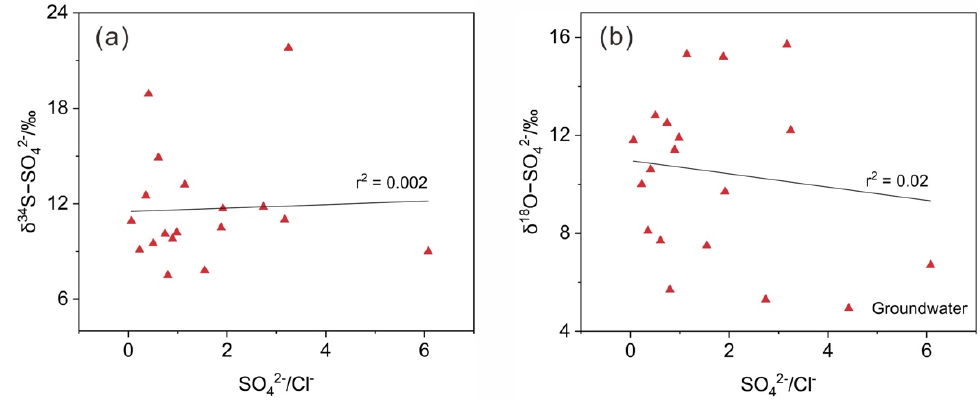
Figure 7. Relationships among δ 34 S − SO 42 − and δ 18 O − SO 42 − and SO 42 − /Cl − of the groundwater in the coal mining area. ( a ) correlations of SO 42 − /Cl − and δ 34 S − SO 42 − ; ( b ) correlations of SO 42 − /Cl − and δ 18 O − SO 42 − .